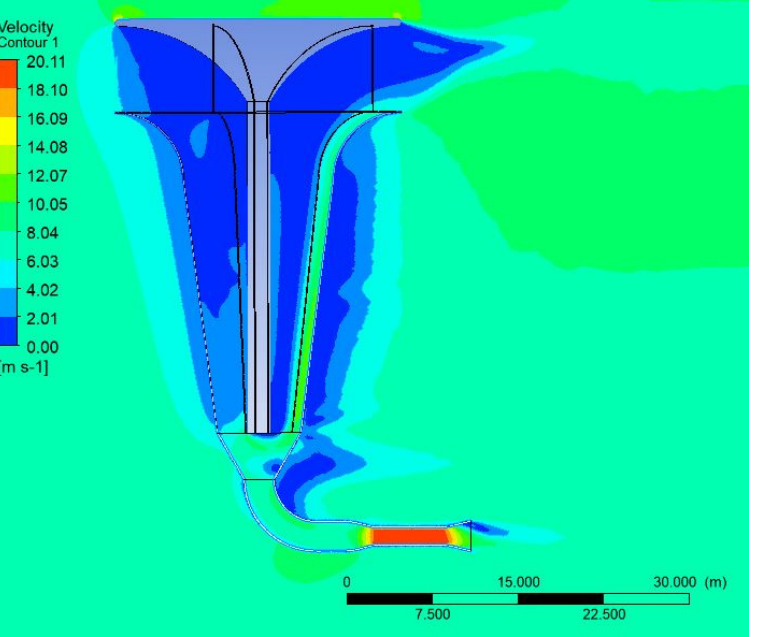
Figure 12. Velocity profile of the omni-directional wind funnel with free-stream wind speed of 7.4 m/s.